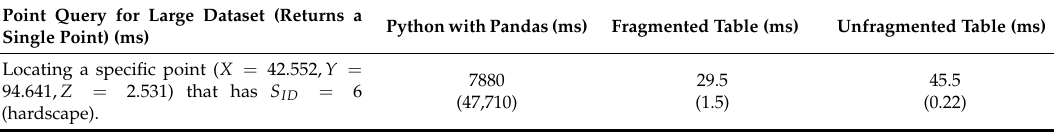
Table 7. The time in milliseconds to locate a single point in the LARGE dataset. For the Python approach, the time in parentheses is the time needed to create an index after loading the file. For the two table approaches, the time in parentheses is the time for a hot query. Point Query for Large Dataset (Returns a Single Point)